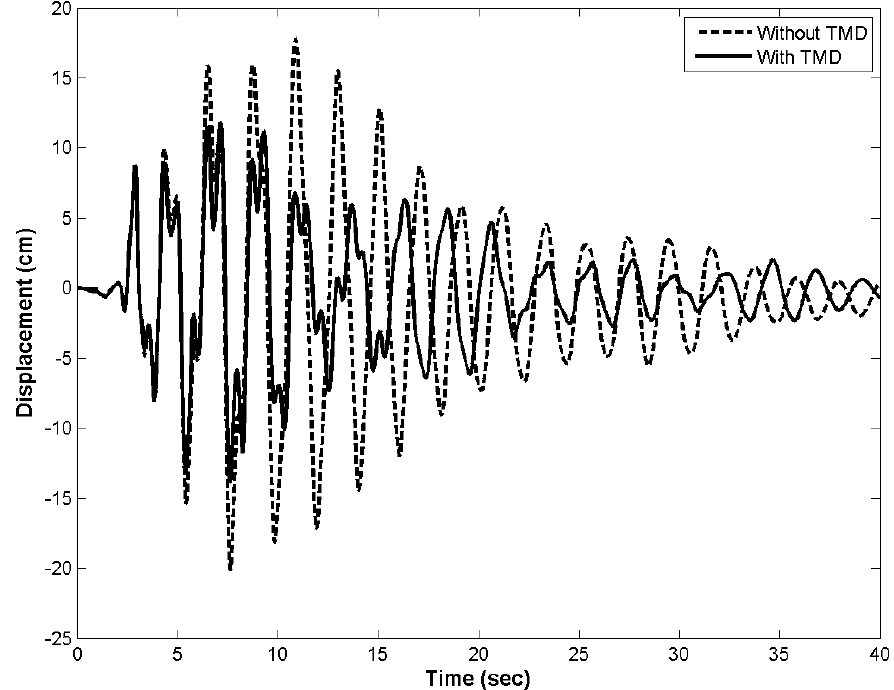
Fig. 8. Displacement Results for the Roof of a First Floor Irregular Structure Subjected to the Loma Prieta Earthquake (PGA = 0.1g).